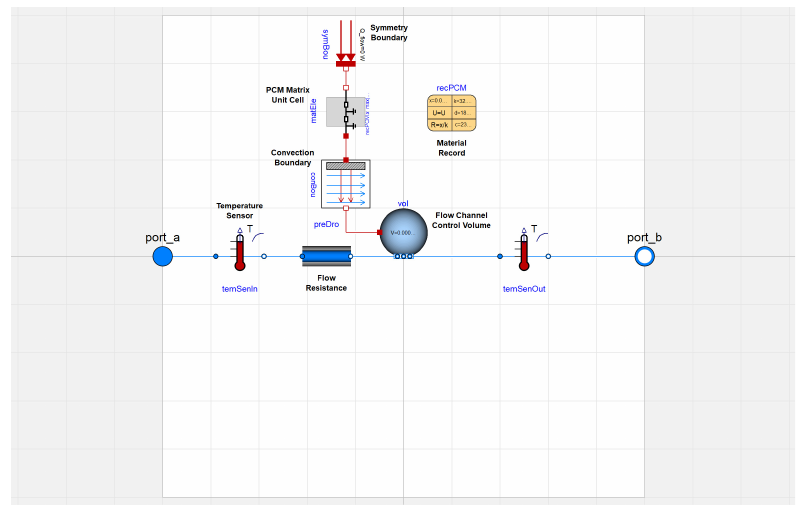
Figure 3. Preliminary model of a single PCM heat exchanger element in